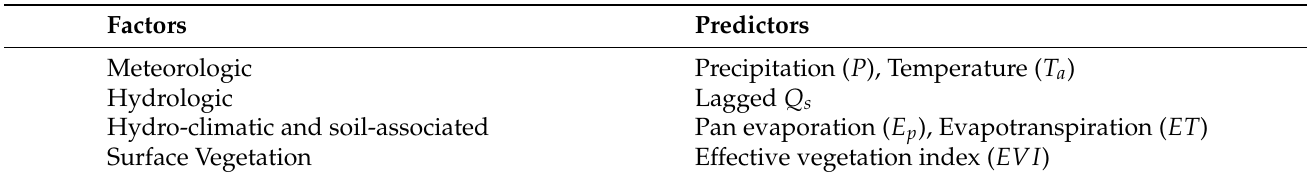
Table 4. Factors and predictors used in IAI-based streamflow